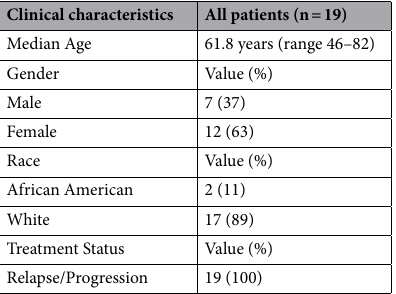
Table 2. Clinical characteristics of patients with multiple myeloma.